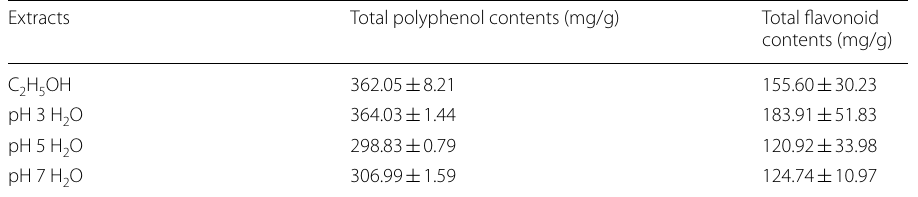
Table 1 Total polyphenol and total flavonoid contents of AE Extracts Total polyphenol contents